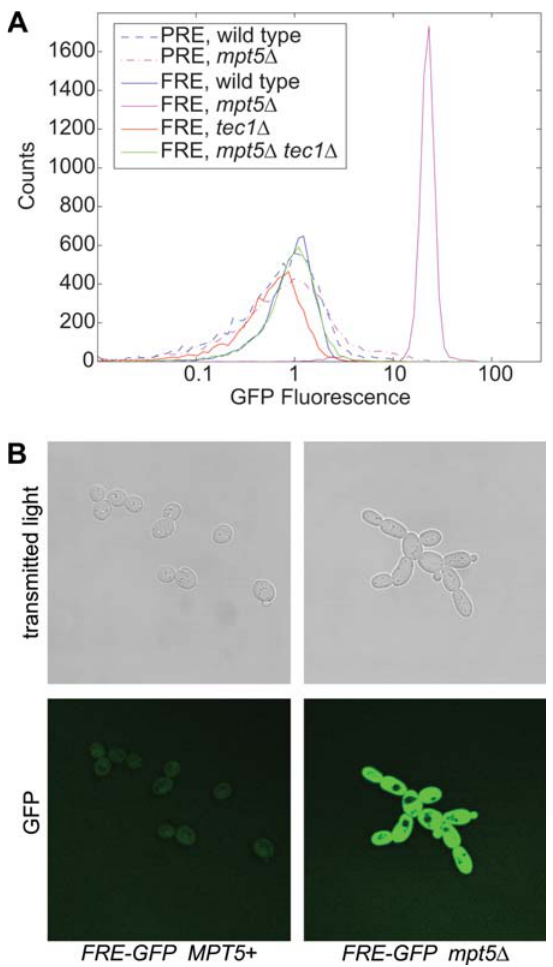
Figure 6. Specific inhibition of fMAPK pathway output by MPT5 . (A) Diploid strains with either a minimal filamentation-MAPK-pathway output reporter (FRE-GFP) or a mating-MAPK reporter (PRE-GFP) and the indicated genotypes were grown under yeast-form conditions and subjected to flow cytofluorometry. (B) The morphology and fluores- cence of MPT5 + and mpt5 D diploid cells with FRE-GFP were imaged by transmitted light and confocal fluorescence microscopy.